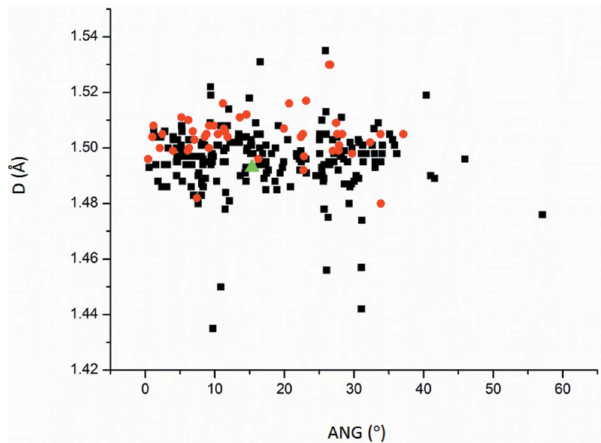
Figure 1 Dependence of the C—C bond distance D , which interconnects the pyridine and the amide groups, on the interplanar angle (ANG) between these groups in 3-pyridinecarboxamide molecules (black squares) or 3- carbamoylpyridin-1-ium molecules (red circles). The interplanar angle has been calculated from the non-hydrogen atoms of these groups. The title structure, which belongs among 3-pyridinecarboxamide molecules, is depicted by a green triangle.